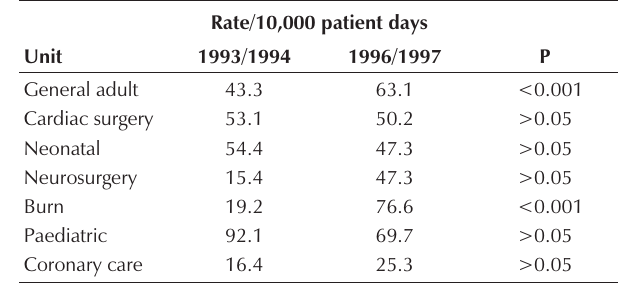
Nosocomial blood stream infection rates for selected medical services at the University of Alberta Hospital